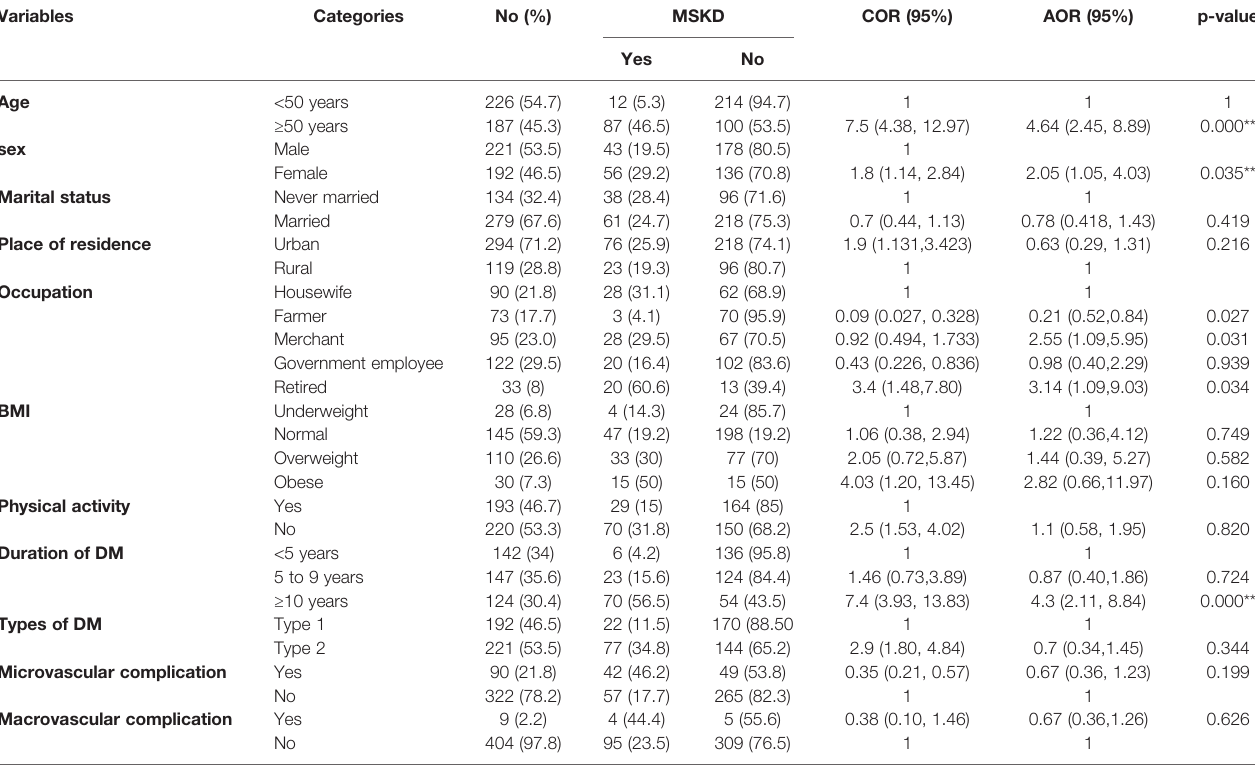
TABLE 4 | Bivariate and multivariate logistic regression analyses of factors associated with MSKD among diabetic patients at FHCSH, Bahir Dar, Northwest Ethiopia, 2020 (n = 413).